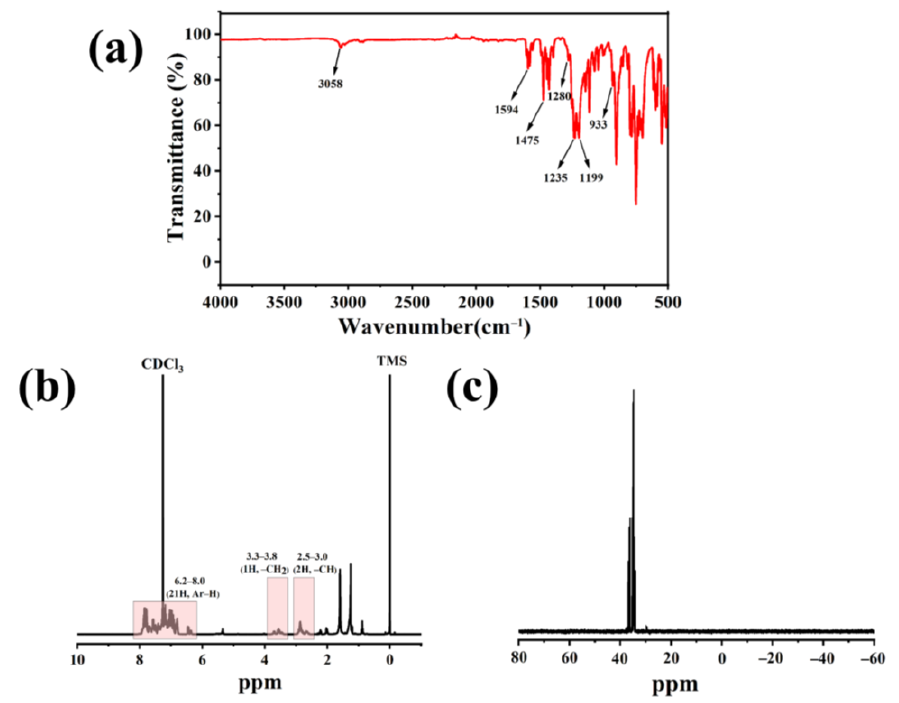
Figure 1. ( a ) FTIR spectra, ( b ) 1 H NMR spectra and ( c ) 31 P NMR spectra of PBDOO. Table 1. Wavenumber and corresponding chemical groups in Thermogravimetric analysis (TGA) and Thermogravimetric differentiation analysis (DTG) curves of PBDOO under nitrogen and air atmospheres are shown in Figure 2. The corresponding data are displayed in Table 2. Among them, T 5% is defined as the tempera- ture at 5% weight loss, T max is defined as the temperature at which the maximum weight loss rate is, and the temperature selected for the char residues is 800 °C.